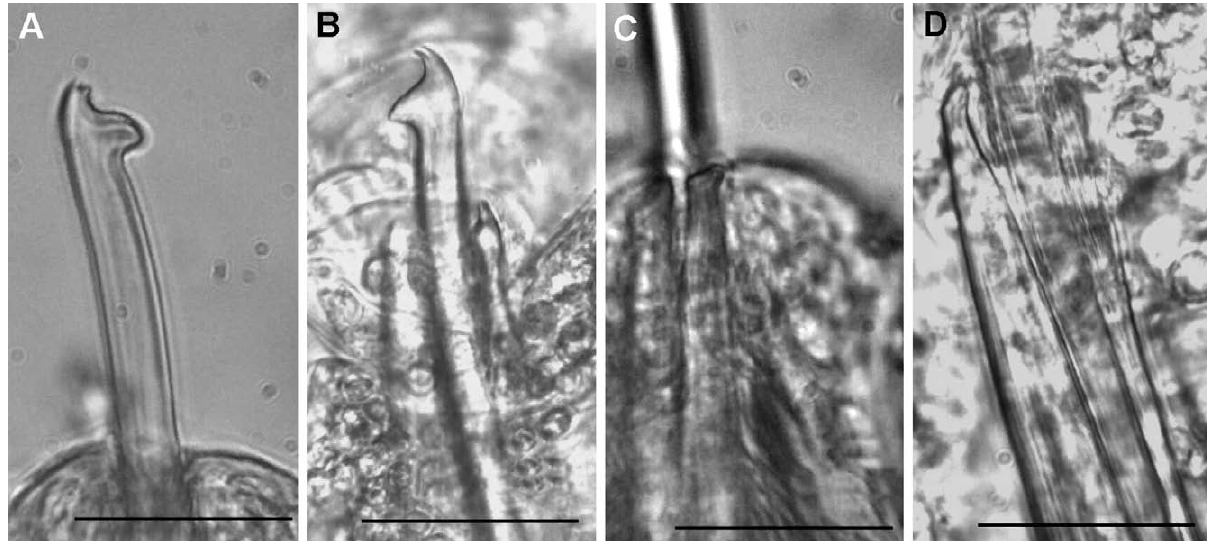
Fig . 5. – Comparative photographs of mid-body chaetae and aciculae of Haplosyllis aplysinicola n. sp. (A, C) (INV-ANE 3456) and Haplo­ syllis navasi n. sp. (B, D) (INV-ANE 3454). Scale bars 20 m